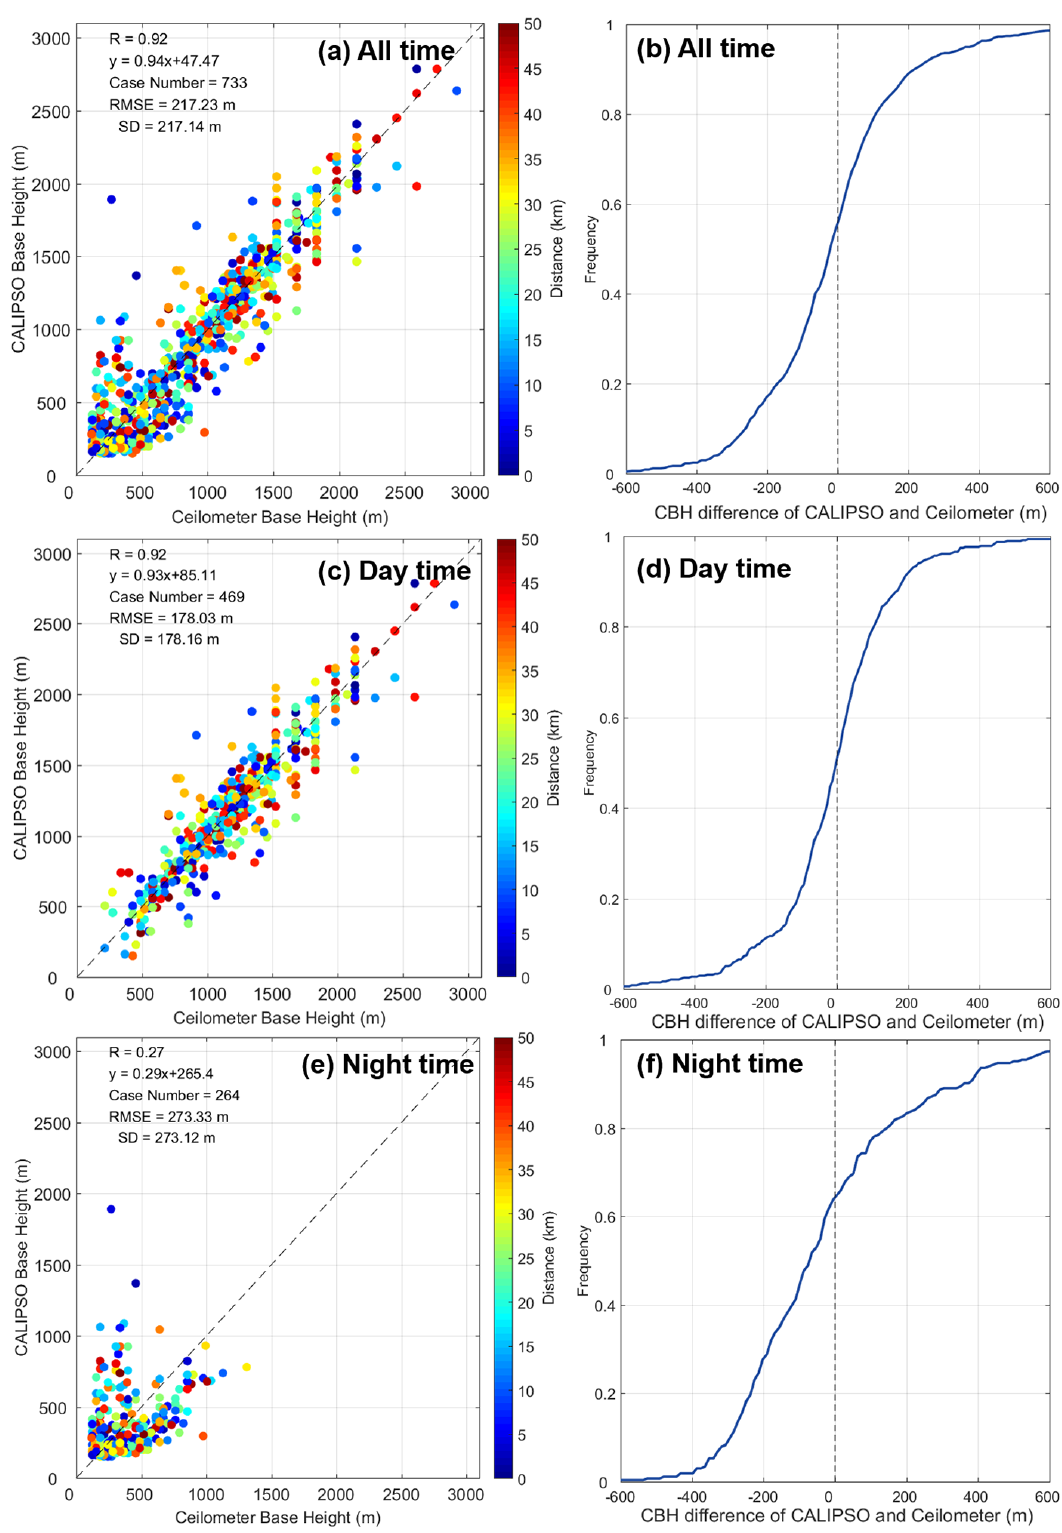
Figure 8. Validation of CALIPSO-retrieved CBH against 138 continental ceilometer sites in the southern Great Plains in 2017–2020. (a) Scat- ter plot of CALIPSO CBH and ceilometer CBH for all time. The color represents the shortest distance from the CALIPSO ground track to the ceilometer site. (b) Cumulative distribution of the difference between CALIPSO CBH and ceilometer CBH for all time. Panels (c) and (e) and panels (d) and (f) are the same as panels (a) and (b) but for daytime and nighttime,